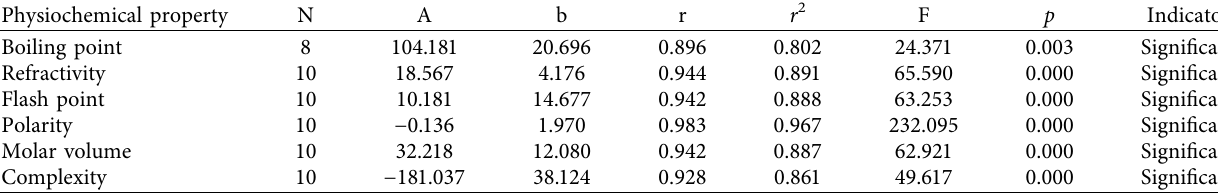
Table 9: Statistical parameters used in the QSPR model of HM(G).